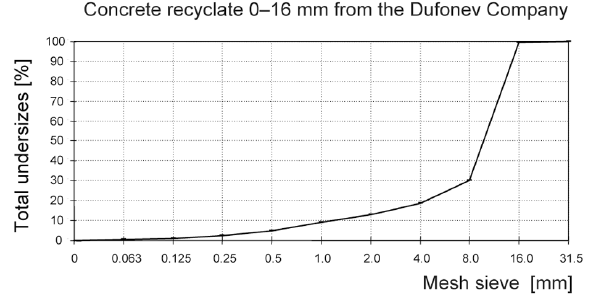
Fig. 1. Grading curve of natural concrete recyclate